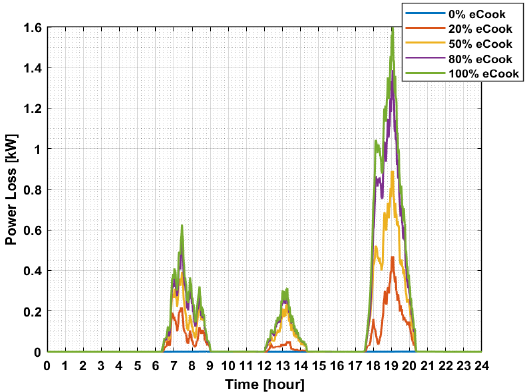
Figure 10. System power loss for different eCook penetrations.